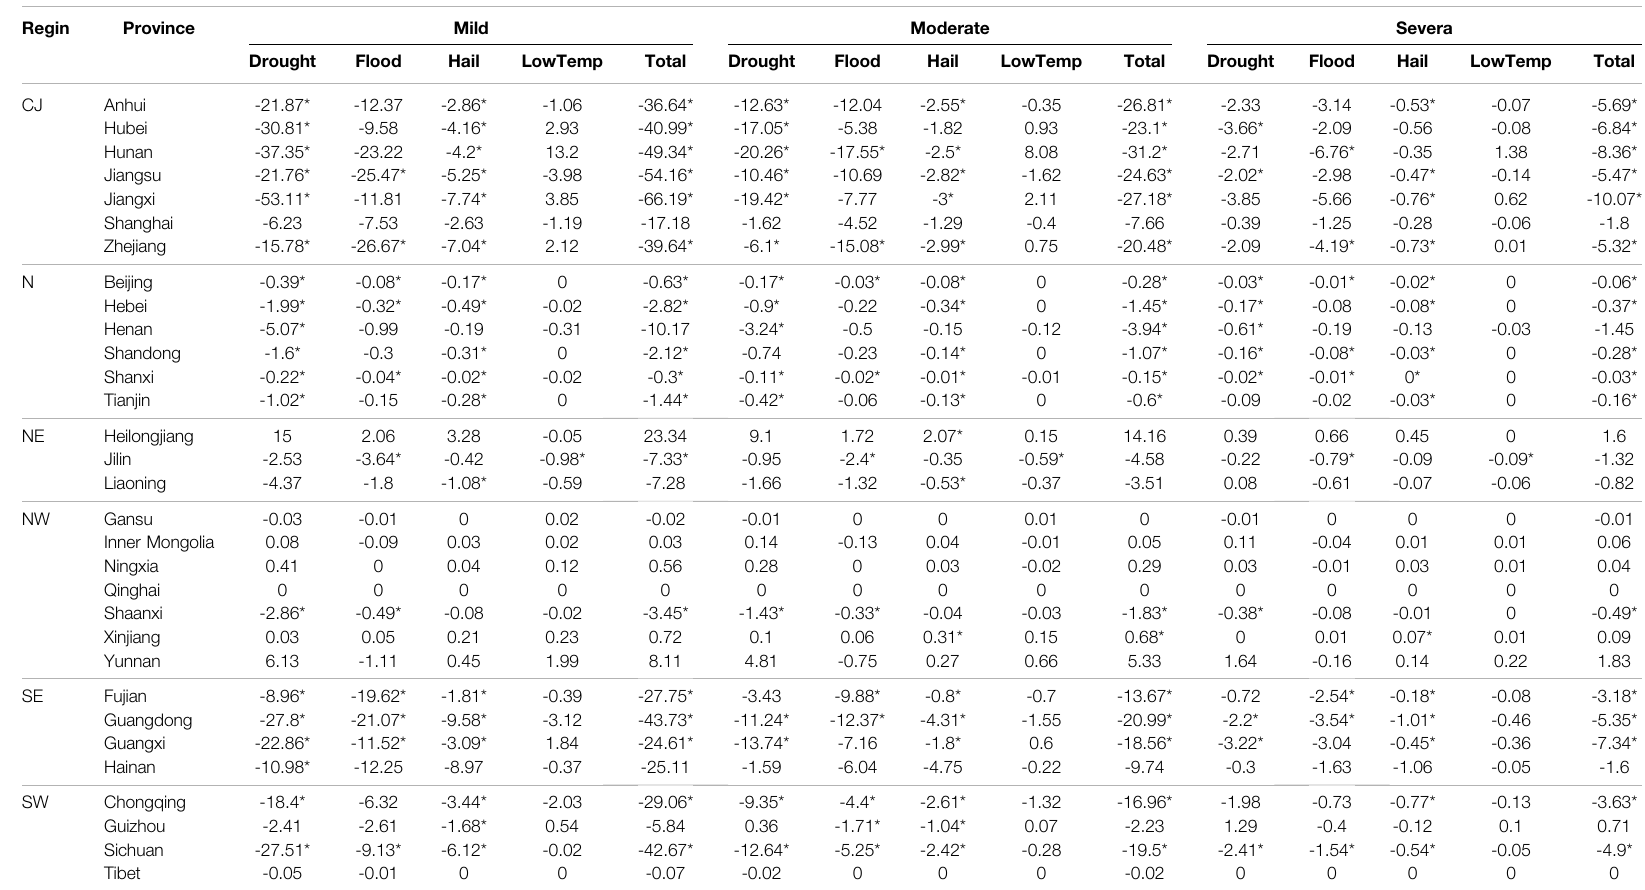
TABLE 2 | Linear changes in the rice cultivation area affected by different natural disasters from 1988 to 2020. * indicates the presence of statistical signi fi cance (Ps < 0.05). Regin Province